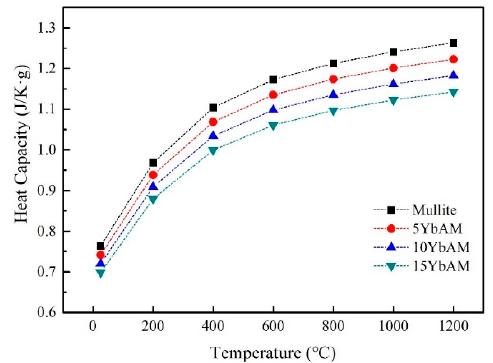
Figure 6. The heat capacity of the samples at 25 to 1200 °C.